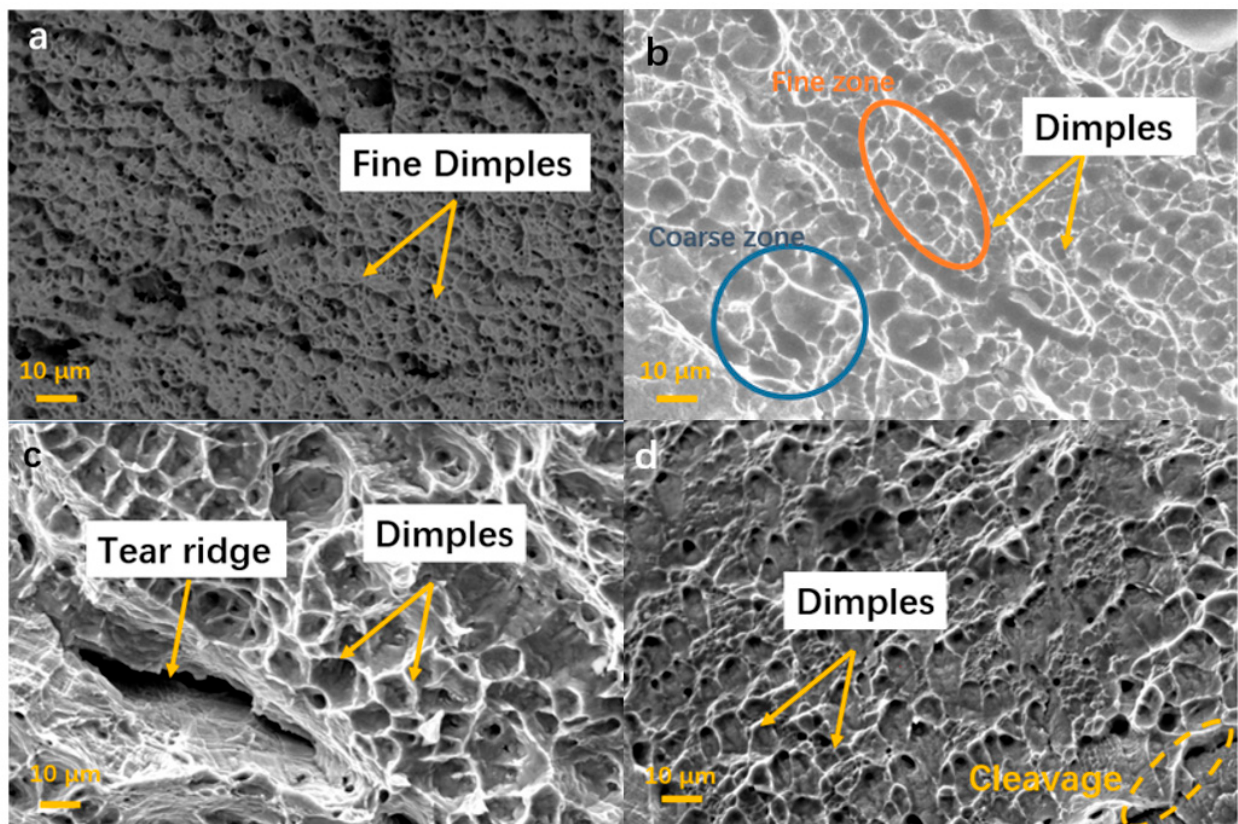
Figure 11. Tensile test fracture surface of ( a ) base metal, ( b ) no-flux TIG welding, ( c ) A-TIG weldments with microscale Fe 2 O 3 flux, and ( d ) A-TIG weldments with nanoscale Fe 2 O 3 flux.